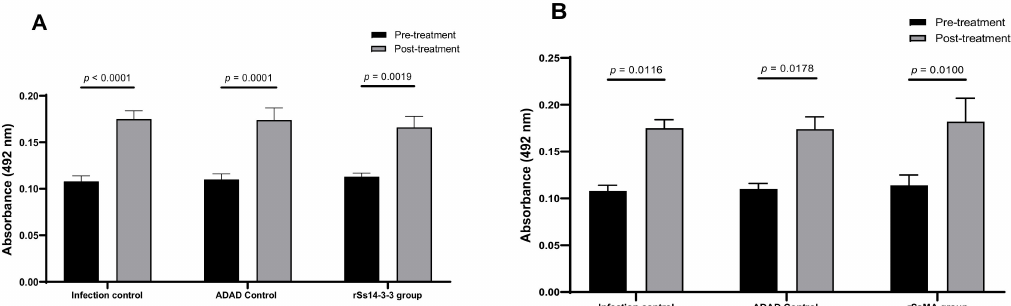
Figure 5. Serum levels of anti-14-3-3 IgG ( A ) and anti-MA IgG ( B ) in mice before and after the treatment (immunization and infection). IgG levels were measured by indirect ELISA by coating the plates with 2 µ g/mL of 14-3-3 protein or 2 µ g/mL MA protein per well, respectively. ( A ) IgG levels against rSs14-3-3 protein; ( B ) IgG levels against rSsMA protein. Bars represent means ± SEM. Differences between groups were determined by two-way ANOVA. The IgG levels are significantly increased after the assay (( A ): F (1,42) = 70.24; p < 0.0001; ( B ): F (1,42) = 37.08; p < 0.0001). Post-hoc Tukey’s honestly significant difference (HSD) test p -values are shown in the